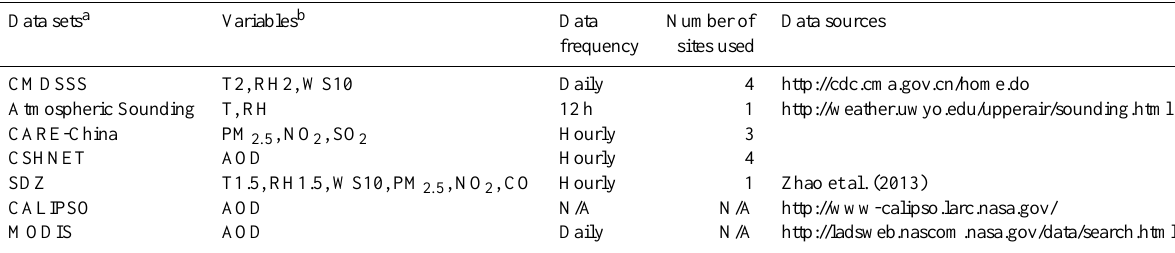
Table 1. Observation data and variables used in this study. Data sets a